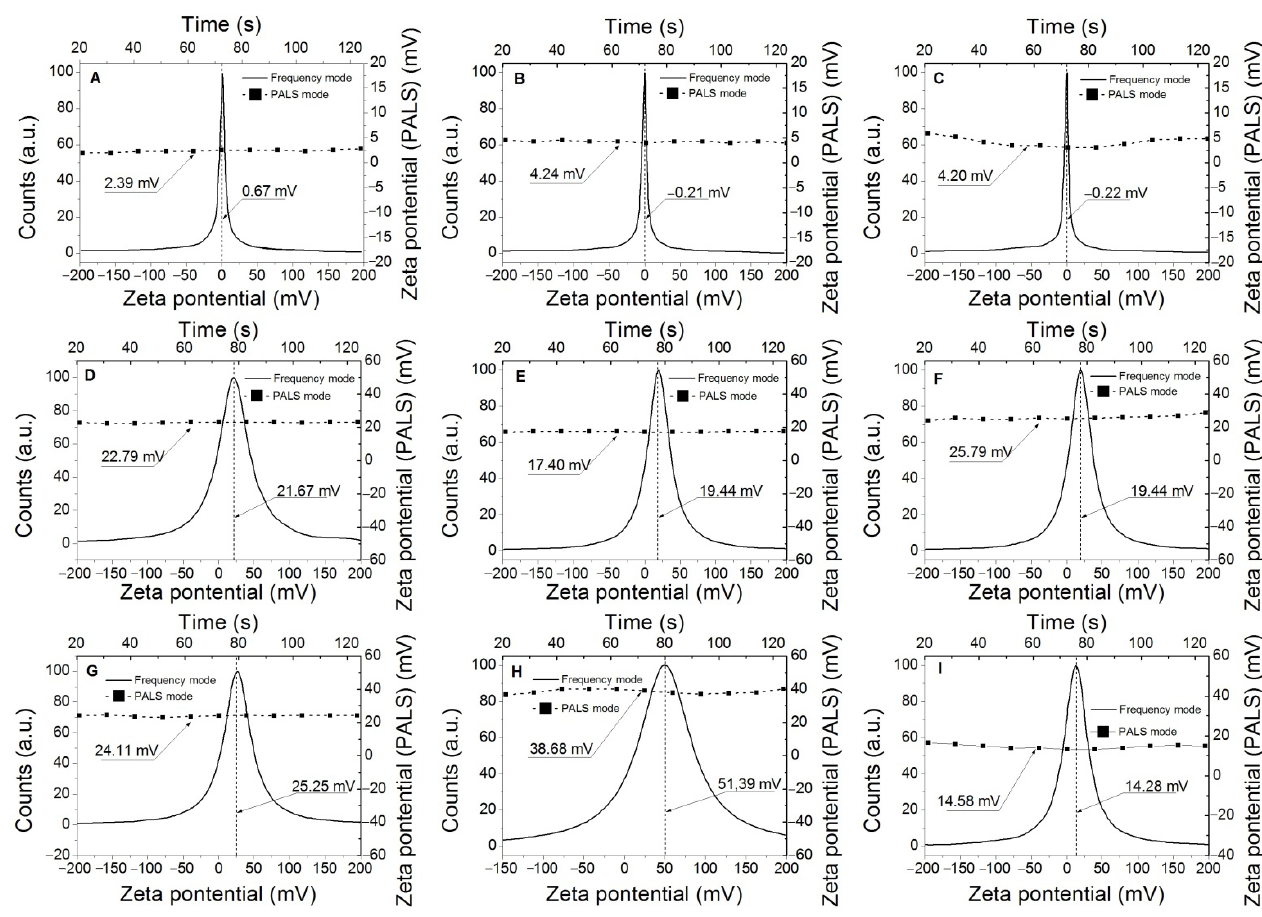
Figure 8. Zeta potential distribution of pure and wastewater: ( A ) WC. ( B ) WSM. ( C ) WSL. ( D ) WC + HNa. ( E ) WSM+ HNa. ( F ) WSL + HNa. ( G ) WC + HK. ( H ) WSM+ HK. ( I ) WSL + HK.